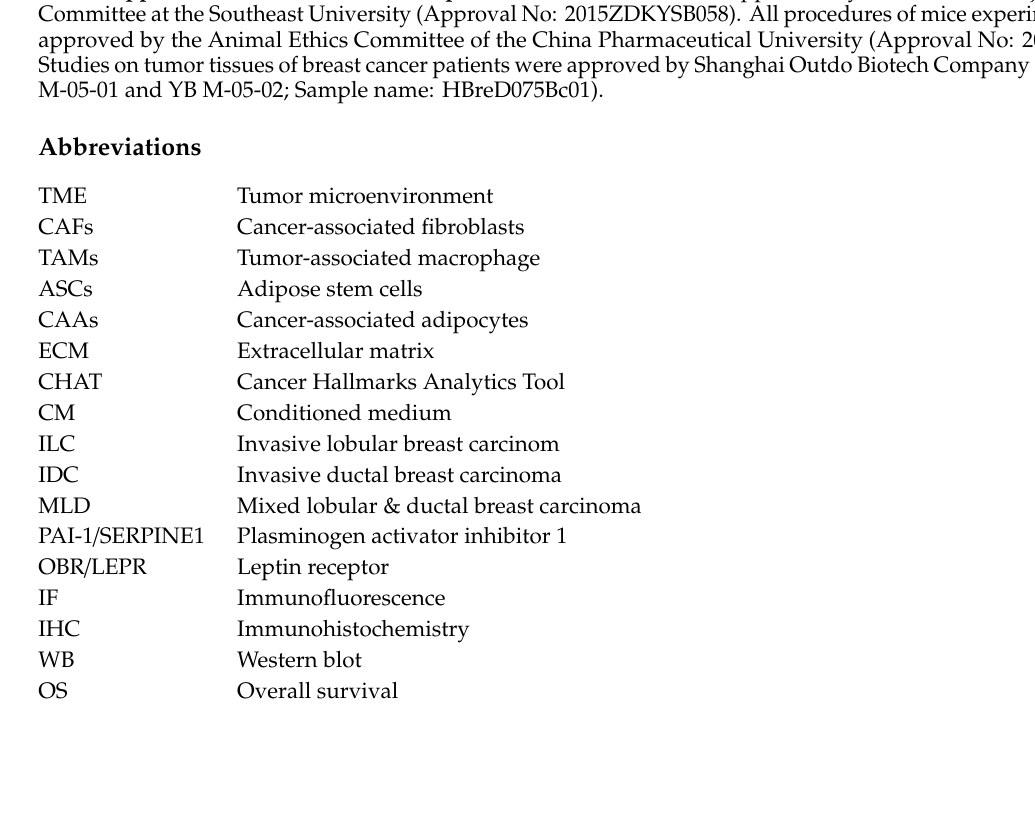
Table S6: Correlation of PAI-1 and adipokine receptors in breast cancer by the analysis of TCGA dataset. Table S7: Predicted miRNAs targeting PAI-1. Table S8: Predicted transcription factors upstream of miR-34a. Table S9: Potential binding sites of STAT3 at PAI-1 promoter. FigureS1: Quantitative results and loss and gain e ffi ciency of OBR, Figure S2: miR-34a and STAT3 were involved in the regulation of leptin / OBR on PAI-1, Figure S3: Expression of PAI-1 in di ff erent breast cancer cell lines, Figure S4: Quantitative results and silence e ffi ciency of STAT3, Figure S5: Expression of PAI-1 in di ff erent breast cancer cell